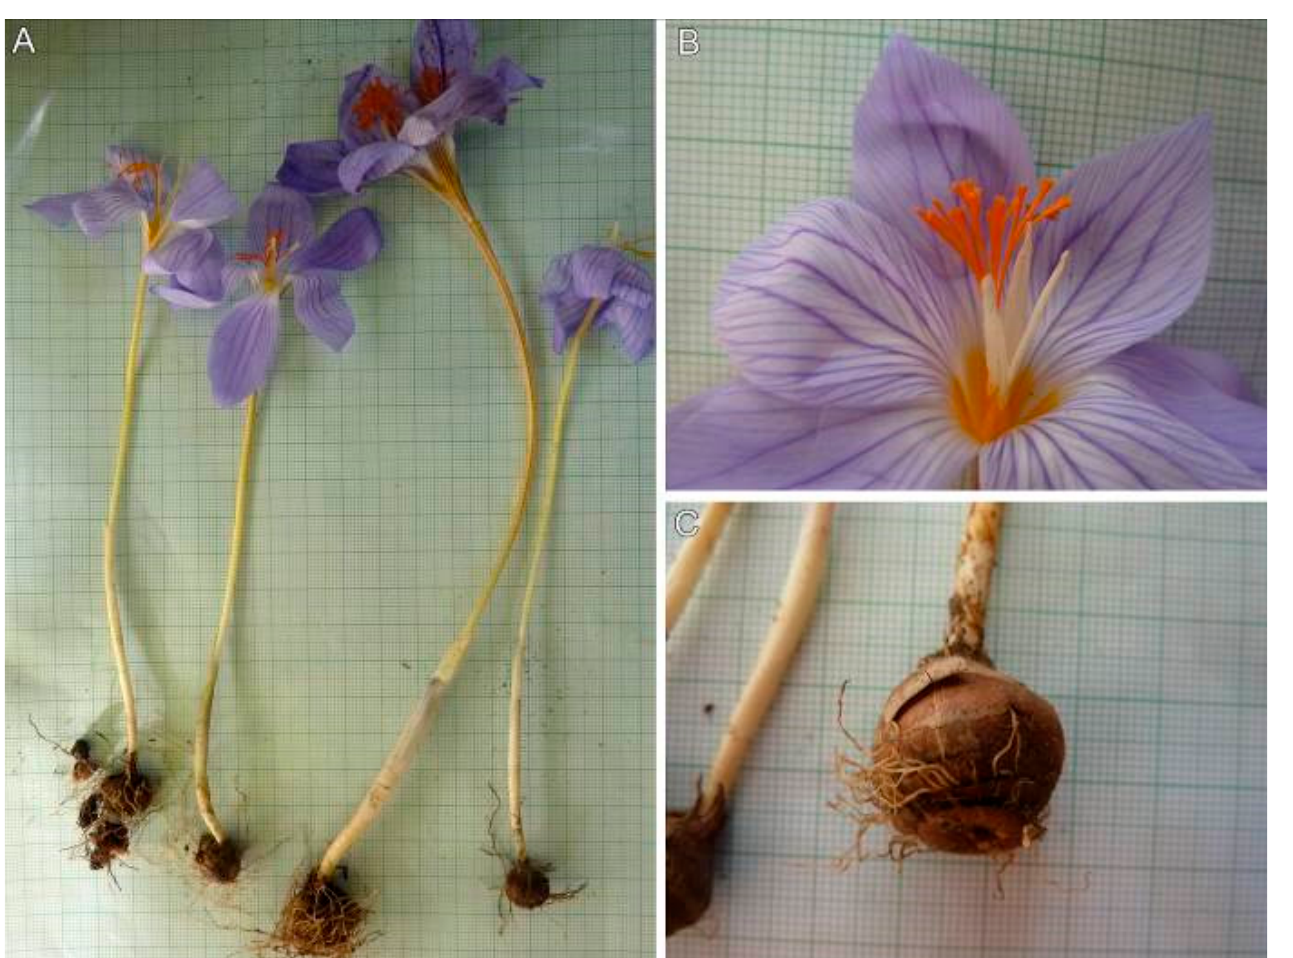
Figure 2. Flower: ( A ) Crocus speciosus ; ( B ) C. pulchellus.